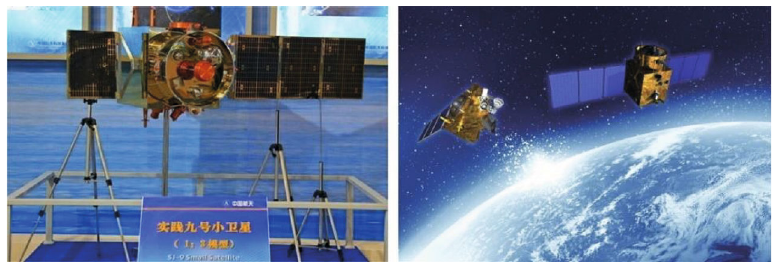
Figure 4: Xenon ion propulsion “ Shijian 9 ” satellite [19].